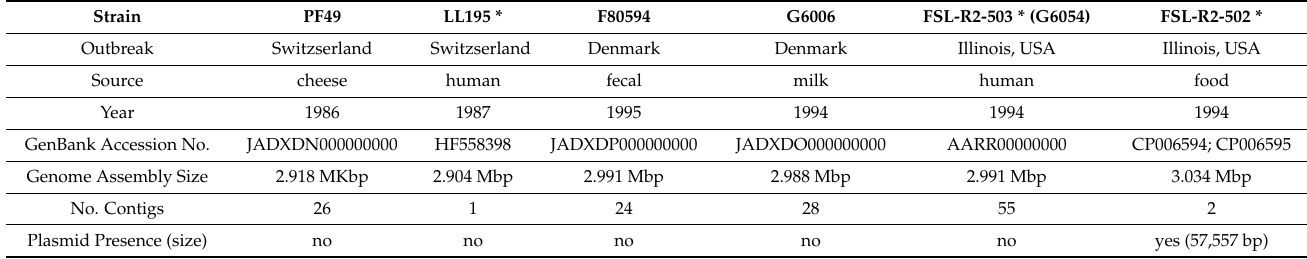
Table 2. General genomic features of L. monocytogenes outbreak